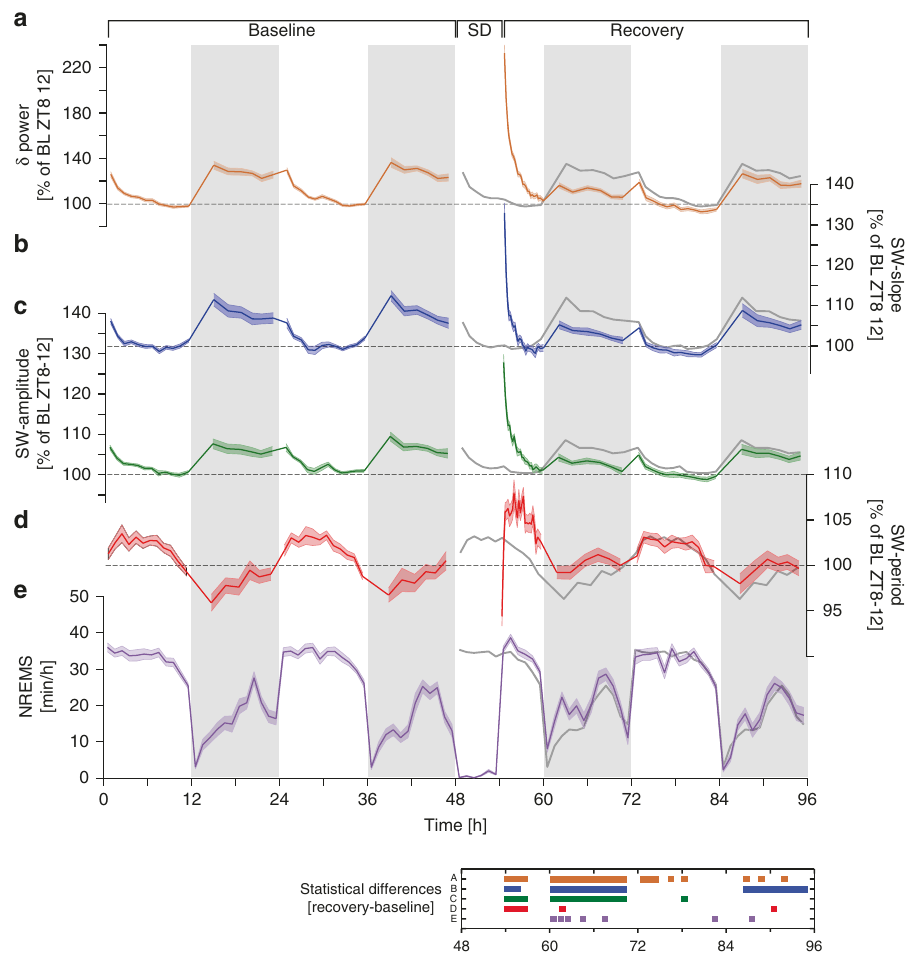
Fig. 1 Frequency- and time-domain analysis of SWs before and after sleep deprivation. a Relative changes in δ -power (0.75 – 4 Hz) followed sleep-wake distribution (see e ) and were highest after sleep deprivation (SD; 48 – 54 h; two-way rANOVA factors SD x time: F 34,1836 = 115.3, p < 1.0E-17). b SW-slope and c SW-amplitude followed nearly identical patterns (two-way rANOVA factors SD x time; SW-slope: F 34,1819 = 45.2, p < 1.0E-17; SW-amplitude: F 34,1819 = 61.6, p < 1.0E-17) although their dynamic range was smaller because power scales as a square to amplitude. d Dynamics of SW-period differed from the other three variables and was at times in opposition (two-way rANOVA factors SD × time: F 34,1819 = 8.3, p < 1.0E-17). Data in a – d represent quantiles [light (12), dark (6), and recovery day 1 light (25)], containing equal numbers of NREMS 4-s epochs, respectively, and were referenced to their respective lowest values reached in baseline (two-day mean of last 4 h of light period). e NREMS time-course expressed as min h − 1 of recording. NREMS increased during recovery compared to baseline (two-way rANOVA factors SD × time: F 34,1836 = 3.1, p = 1.1E-08). All values represent mean ± s.e.m (shading); a , e n = 38, b – d n = 37. Averaged baseline values (Baseline days 1 – 2) are re-plotted during recovery for comparison (dark-gray line). Signi fi cant post-hoc recovery- baseline differences ( p < 0.05) are presented in a color-matched panel ( a – e refer to fi gure panels) below. Note that SW-power, -slope, and -amplitude all fall below baseline during the 1st recovery dark phase. Data are derived from fronto-parietal bipolar EEG